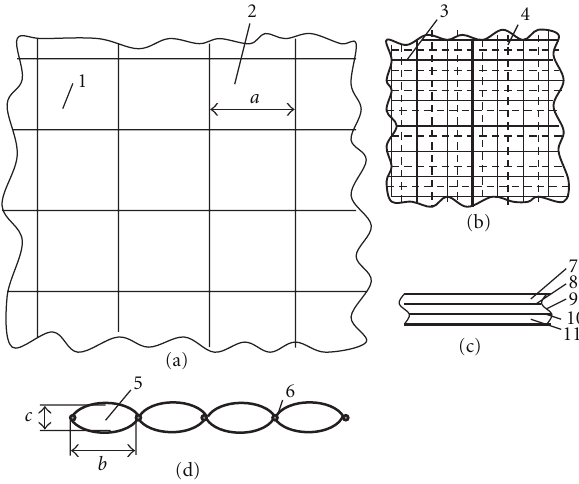
Figure 8: Design of advanced covering membrane. Notations: (a) Big fragment of cover with controlled clarity (reflectivity, carrying capacity) and heat conductivity; (b) small fragment of cover; (c) cross section of cover (film) having 5 layers; (d) longitudinal cross section of cover; (1) cover; (2) mesh; (3) small mesh; (4) thin electric net; (5) cell of cover; (6) margins and wires; (7) transparent dielectric layer; (8) conducting layer (about 1–3 μ ); (9) liquid crystal layer (about 10–100 μ ); (10) conducting layer; (11) transparent dielectric layer. Common thickness is 0.1–0.5 mm. Control voltage is